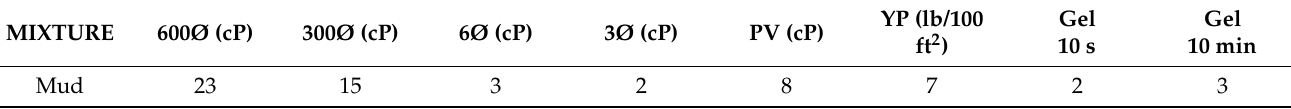
Table 2. Rheological properties of formulated